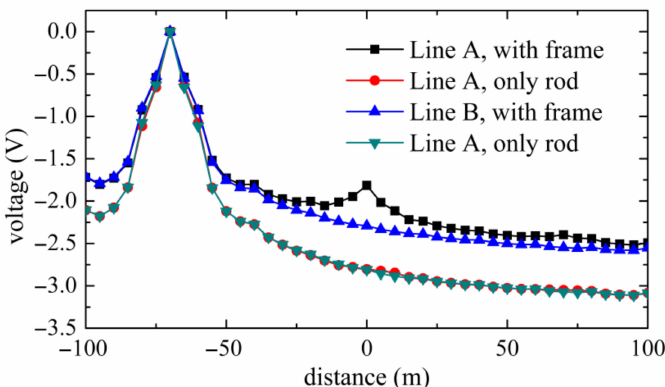
Figure 11. Distribution of the transient potential difference.